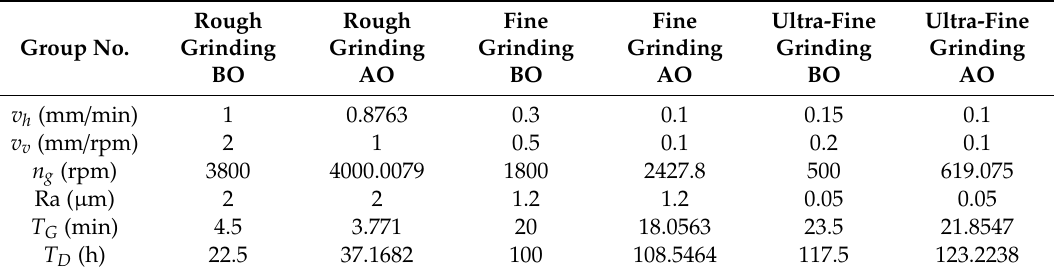
Table 9. The solution results via the dual simplex method. BO: before optimization; AO: after optimization.